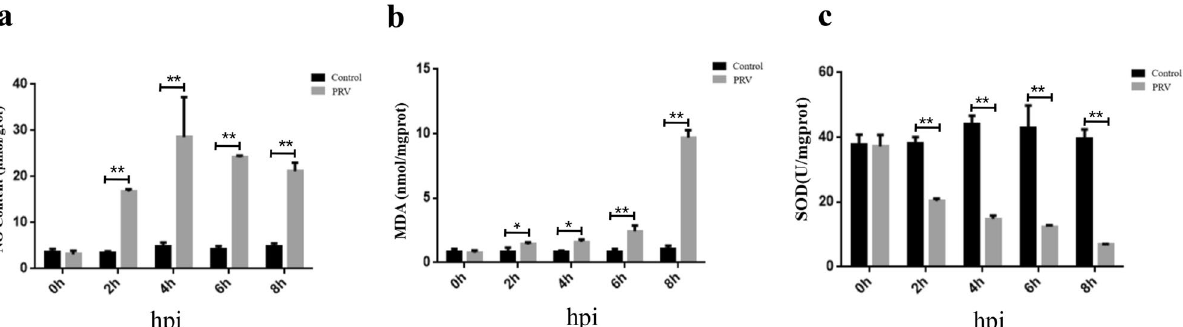
Figure 1. Effects of the duration of pseudorabies virus (PRV) infection on oxidative stress-related markers in hippocampal neurons. ( a ) MDA level; ( b ) NO level; ( c ) SOD activity. MDA malondialdehyde, NO nitric oxide, SOD superoxide dismutase, hpi hours post-infection. n = 3, represents three biological replicates, each performed in triplicate. *P < 0.05; **P < 0.01, based on the two-tailed independent-t test.